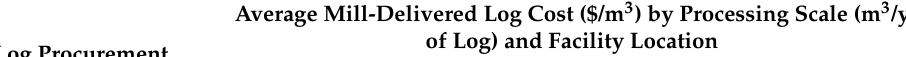
Table 7. Average mill-delivered log cost over 30